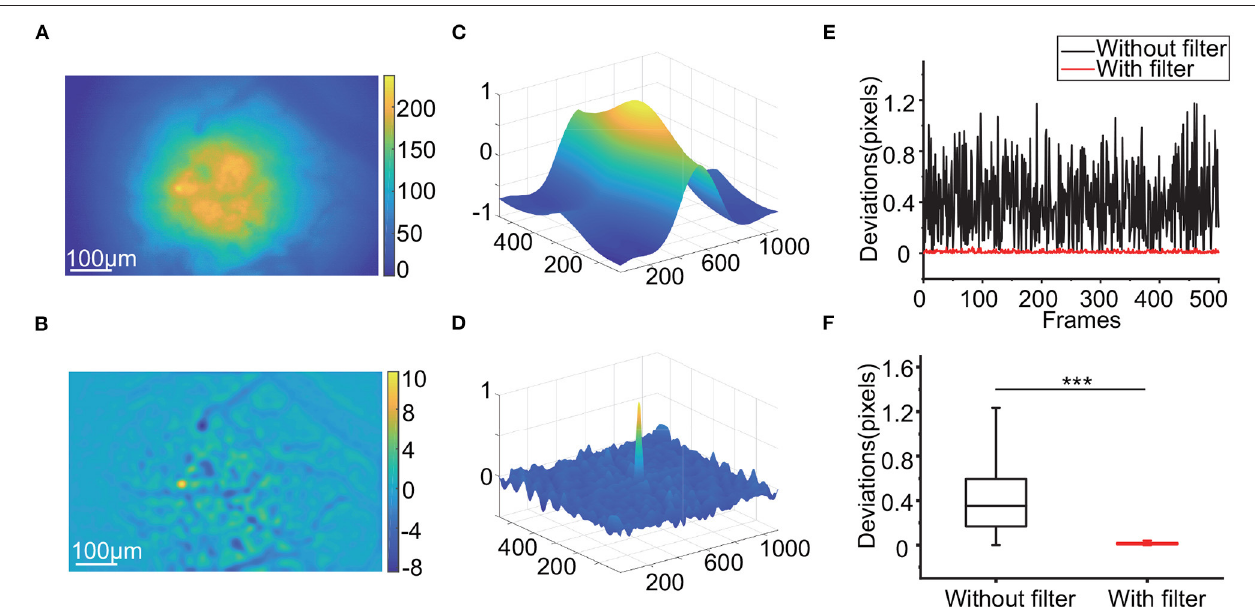
FIGURE 2 | Influence of applying the high-pass filter. (A,B) : Raw calcium image (A) and filtered calcium image (B) . (C,D) : The NCC map calculated by 2 raw calcium images (C) and 2 filtered calcium images (D) . (E,F) : The deviations of a subset of a simulated video (E) and the box-plot of the deviations (F) with and without a high-pass filter during RTMC registration. (*** p < 0.001, Wilcoxon